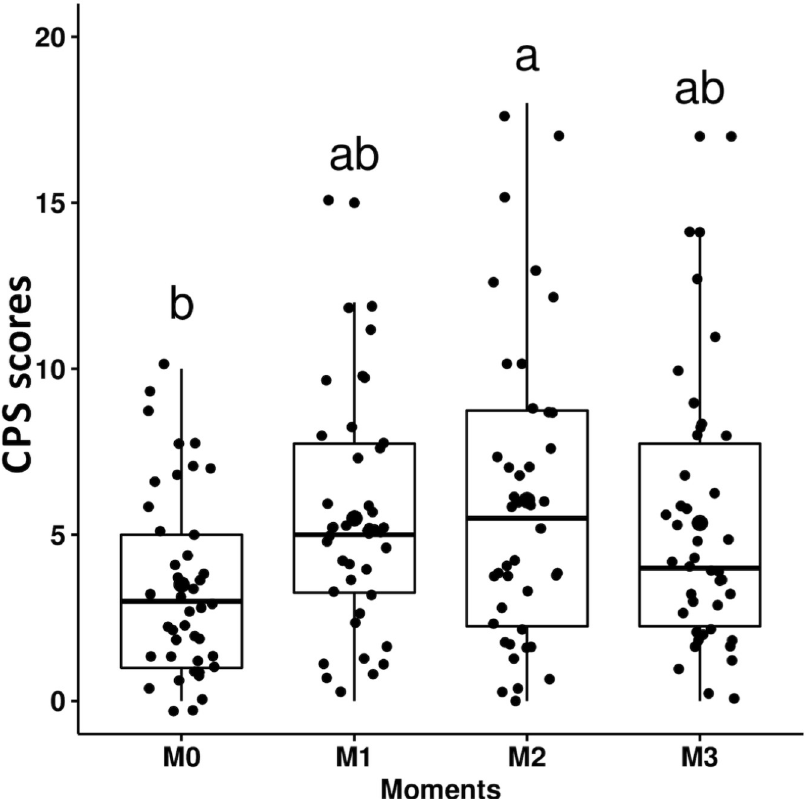
Fig 3. Box plots of the total scores of the Composite Pain Scale (CPS) over time. M0 –before surgery; M1 –up to 4 hours after surgery; M2—up to 3 hours after analgesic treatment; M3–24 hours after surgery. Small letters represent statistically significant differences (a >